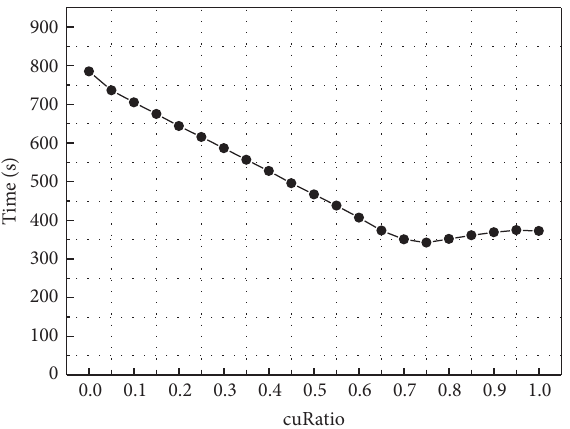
Figure 12: Matrix solving time associated with the cuRatio value.